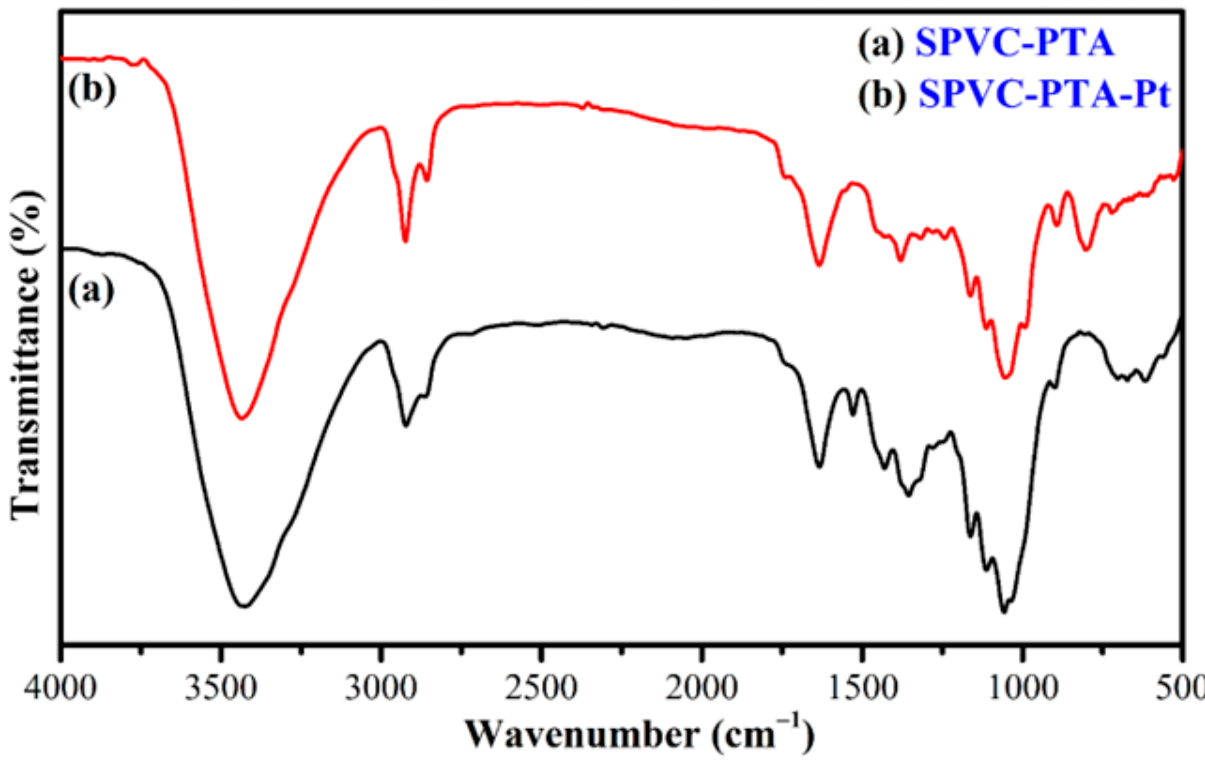
Figure 7. FTIR spectra of the ( a ) SPVC–PTA and ( b ) SPVC–PTA–Pt IPMC membranes.